Question: Write a descriptive caption for this figure.
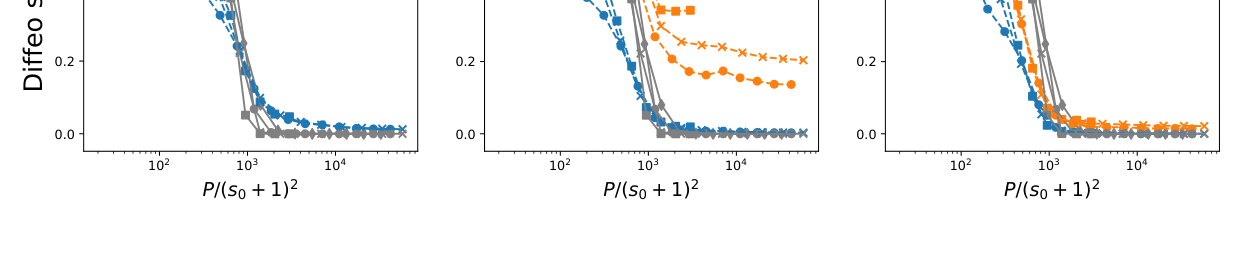
Answer: Top: sensitivity to synonyms exchange Sk,l of a L−layer CNN, trained on the SRHM with L = 2, s = 2 and m = v = 8, versus number of training points P rescaled by prediction Eq. 4. Going from left to right column the network layer k increases from the layer closest to the input to the output. For each column at fixed k there are plotted in color the sensitivities Sk,l to synonyms exchange at the data level l ∈[0, ..., L], and in grey the test error. Different markers stand for different s0. Bottom: same as top, but with the sensitivity to diffeomorphisms Dk,l. The sensitivities S2 and D2 defined in Eq. 6 and Eq. 7 relate to the case k = 2 and l = 1 here.